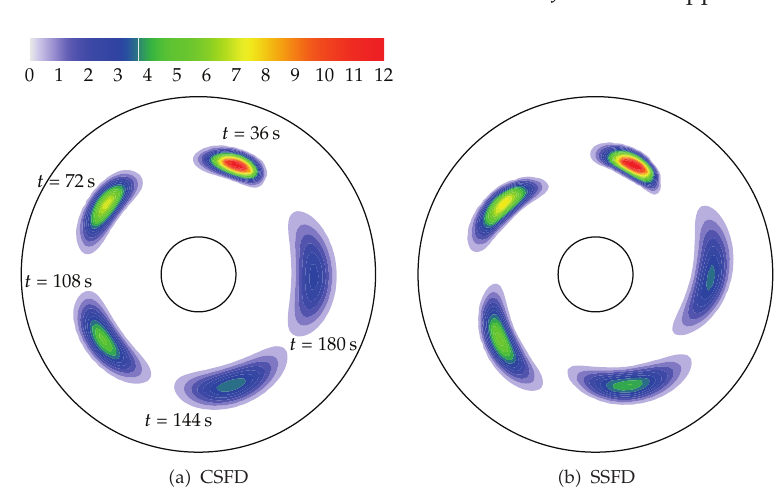
Figure 7: Concentration distribution in coaxial cylindrical container.